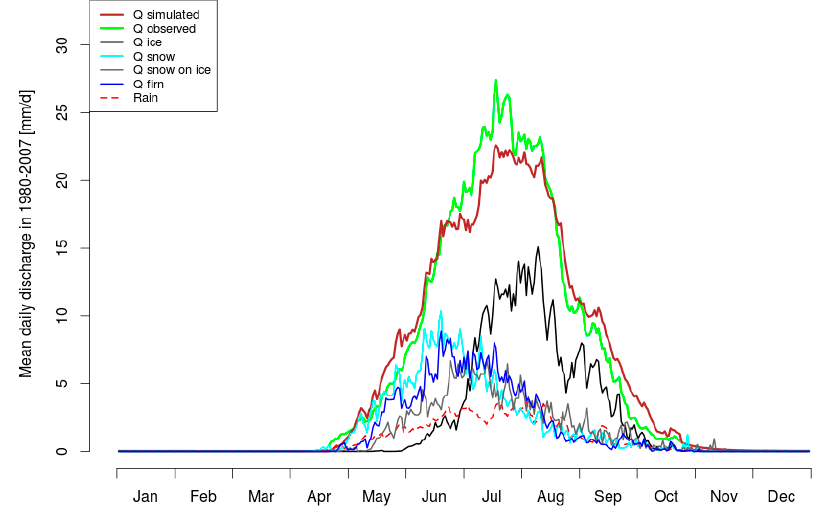
Figure 3. Mean daily simulated and observed streamflow for the Vernagtbach catchment during the period 1980–2007 and its most important simulated components.